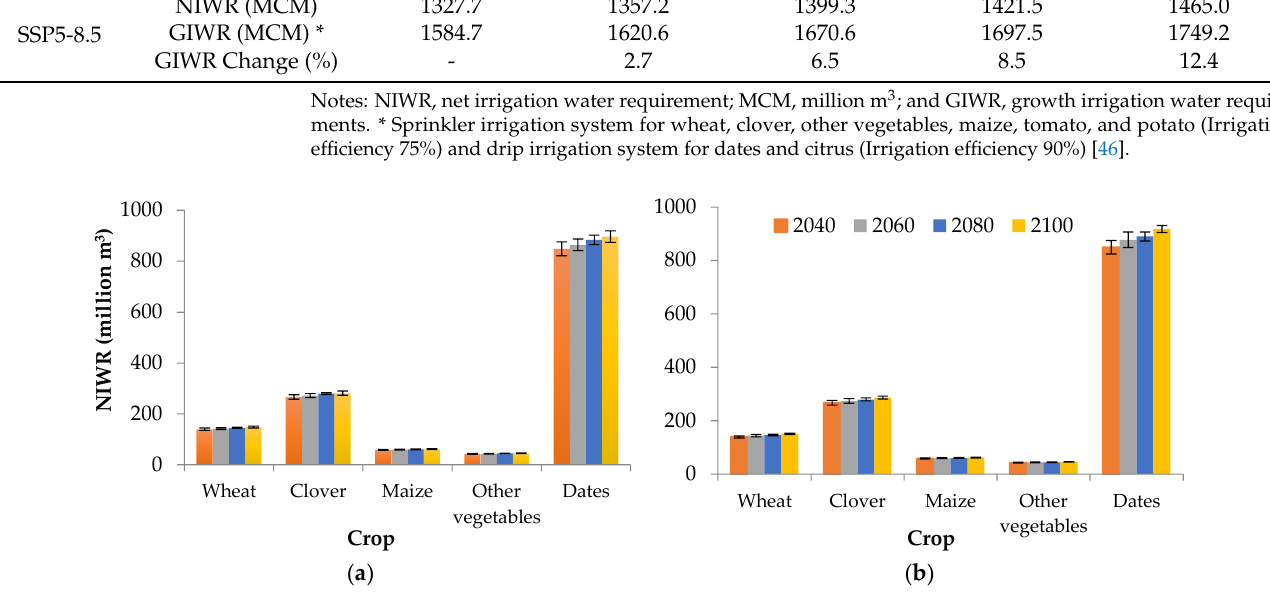
Figure 12. NIWR (net irrigation water requirement) variability in Al Quassim region for five crops and four climate models (indicated by error bar) for 2040, 2060, 2080, and 2100 under ( a ) SSP2-4.5 and ( b ) SSP5-8.5.